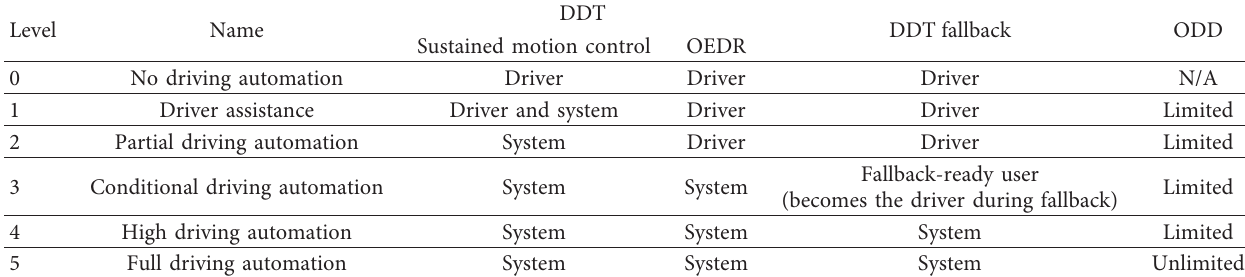
Table 2: SAE automation levels